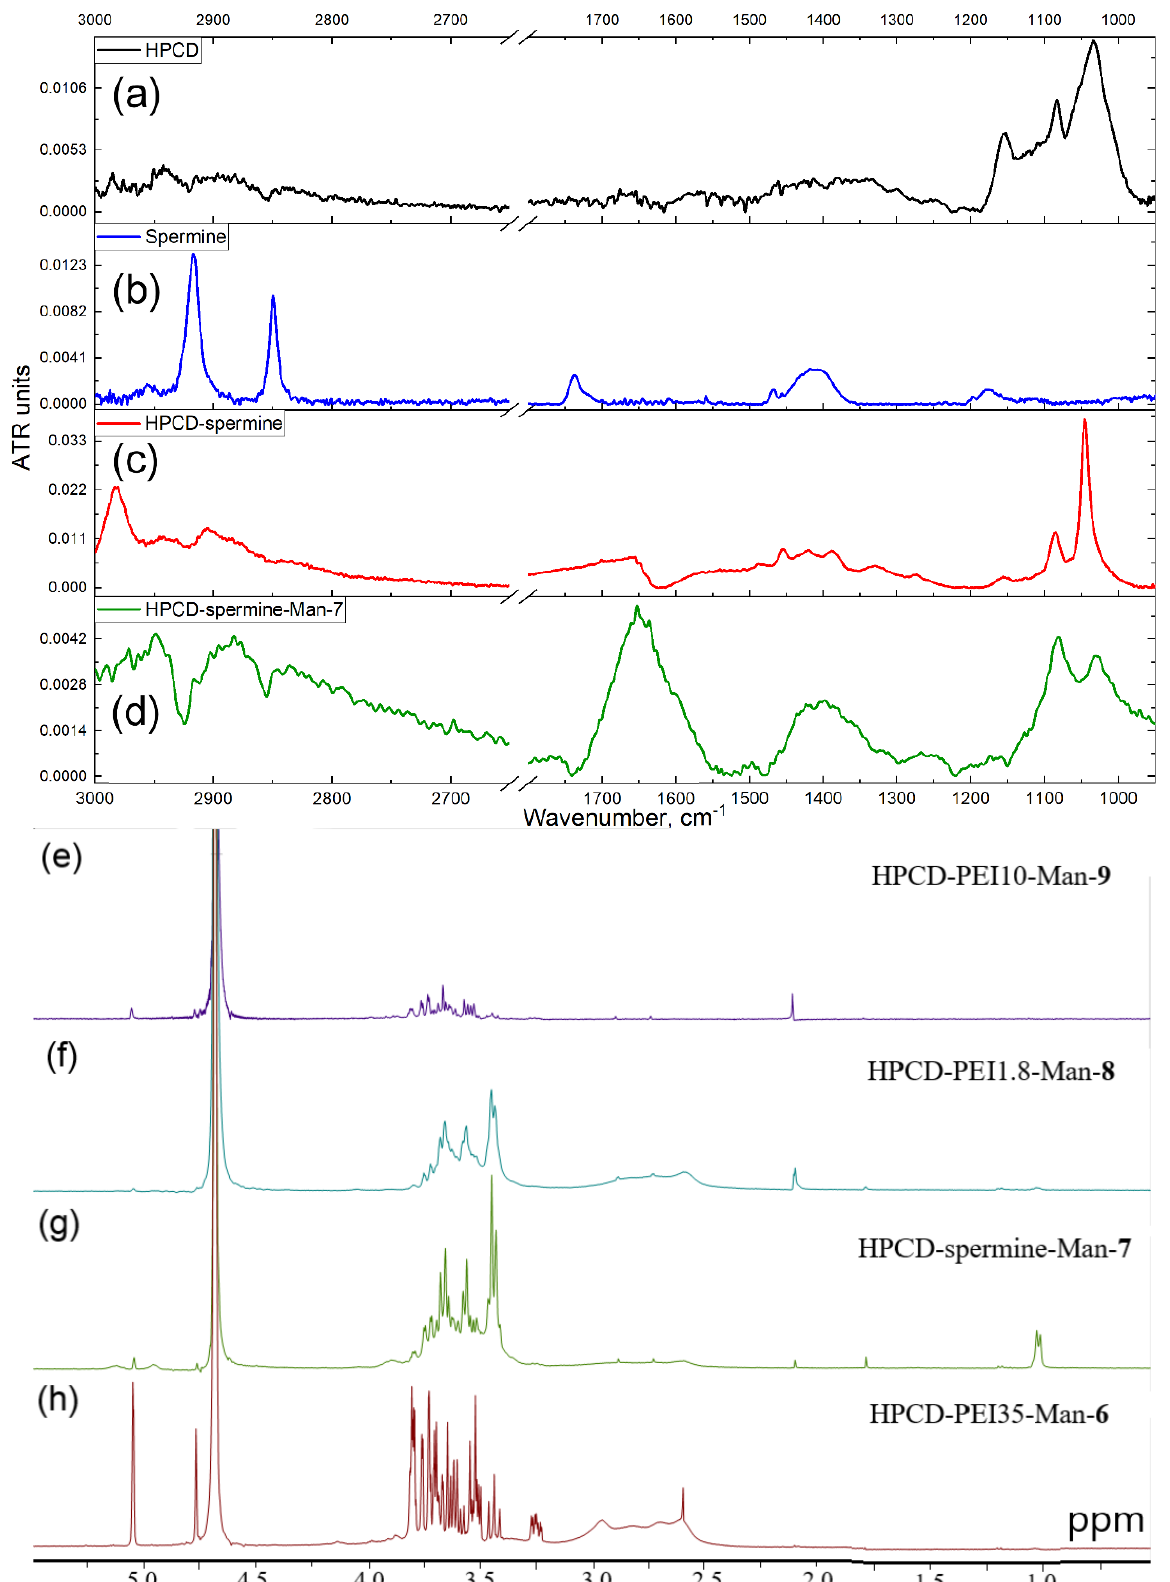
Figure 2. Fourier transform infrared spectra of ( a ) HPCD, ( b ) spermine, ( c ) HPCD-spermine conjugate, ( d ) mannosylated HPCD-spermine-Man- 7. 1 H NMR spectra of conjugates: ( e ) HPCD-PEI10-Man- 9 , ( f ) HPCD-PEI1.8-Man- 8 , ( g ) HPCD-spermine-Man- 7 , ( h ) HPCD-PEI35-Man- 6 . D 2 O, 12 mg/mL 400 MHz.